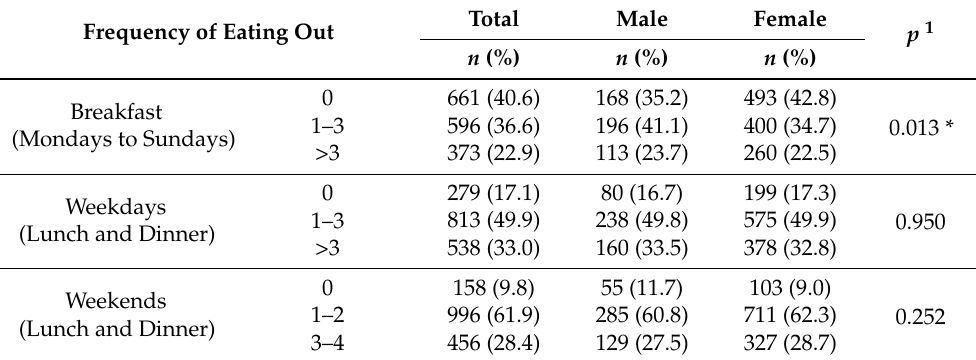
Table 3. Frequency of eating out per week in the last month by gender ( n =